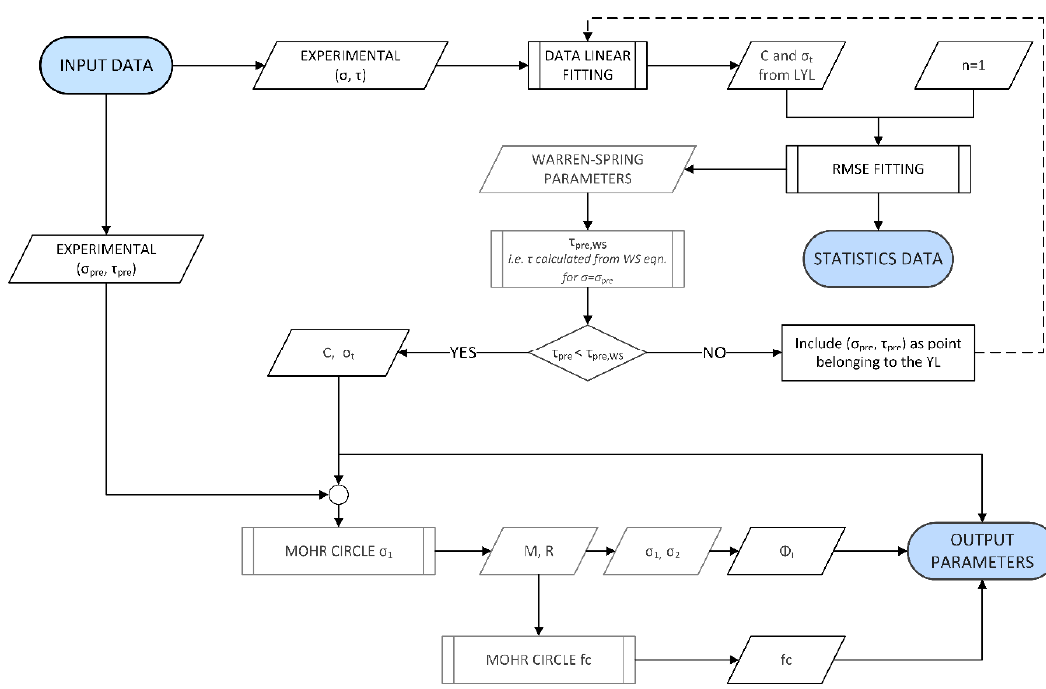
Figure 6. Warren–Spring sub ‐ process structure.